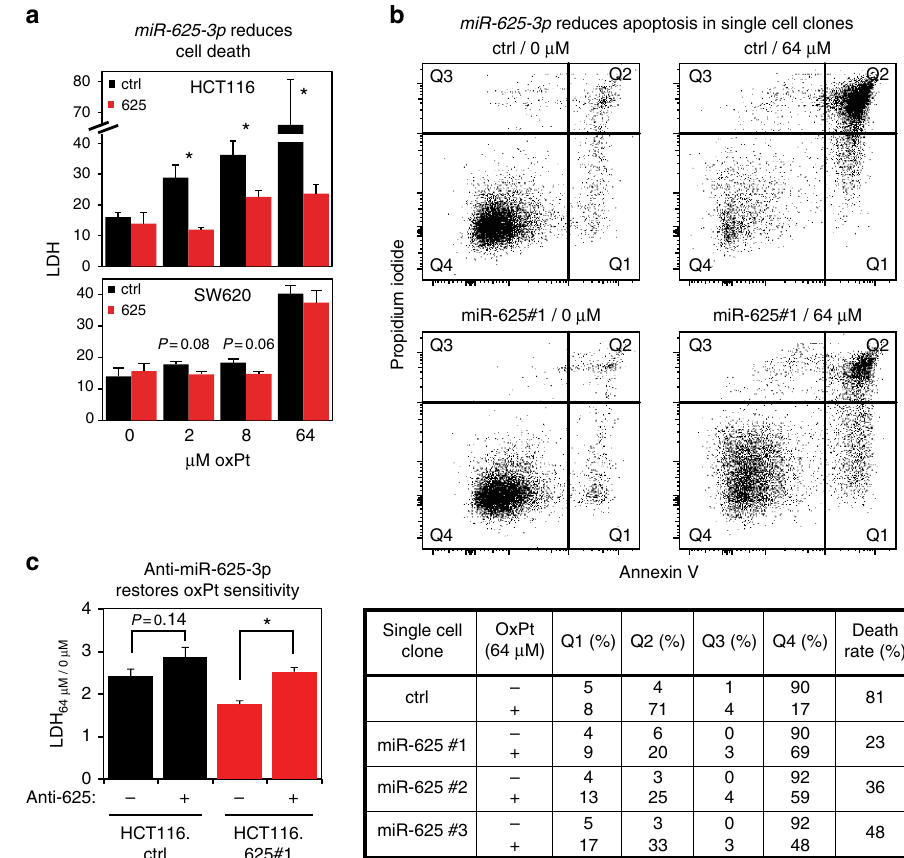
Figure 2 | miR-625-3p inhibits oxPt-induced cell death in CRC cell lines. ( a ) DOX-induced HCT116.625 and SW620.625 together with control cells were treated for 48h with oxPt. Cell death was determined with the LDH assay as 100%*(LDH medium /(LDH medium þ LDH lysate )). Displayed as mean ± s.e.m. ( n ¼ 3). ( b ) DOX-induced HCT116.625 and HCT116.ctrl single colony-derived cells were treated with media containing 0 or 64 m M oxPt for 48h. In the top panel, representative results from HCT116.ctrl and HCT116.625#1 single cell clones are shown. Quadrants Q1, Q2 and Q3 contain early apoptotic, late apoptotic and necrotic cells, respectively, while quadrant Q4 contains living cells. The bottom panel reports the fraction of cells in each quadrant for three independent HCT116.625 single cell clones. The death rate was calculated as 100%*(1 (cid:2) [Q4 64 m M /Q4 0 m M ]). ( c ) HCT116.625#1 and HCT116.ctrl cells were induced with DOX and transfected with 20nM anti-miR-625-3p oligo. Twenty-four hours after transfection, cells were cultivated in 0 or 64 m M oxPt for 48h before cell death was assessed by LDH assay. Data are presented as mean increase in 64 m M oxPt-induced cell death ± s.e.m. ( n ¼ 5). * P r 0.05 ( t